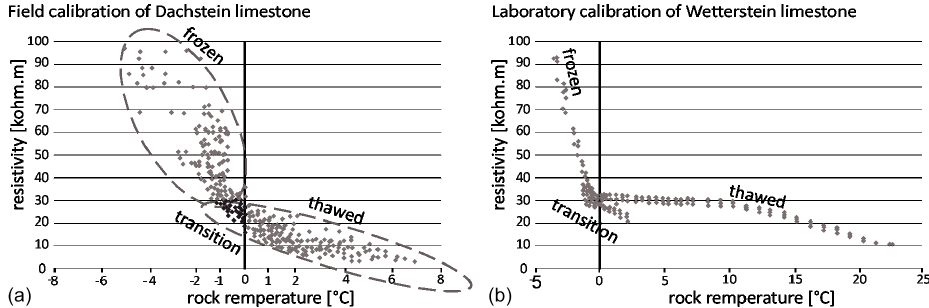
Figure 4. Comparison of small-scale ERT (a) at MS-K and (b) in laboratory (Krautblatter et al., 2010) calibration measurements. Table 2. ERT profiles information. Abbreviation: PF,